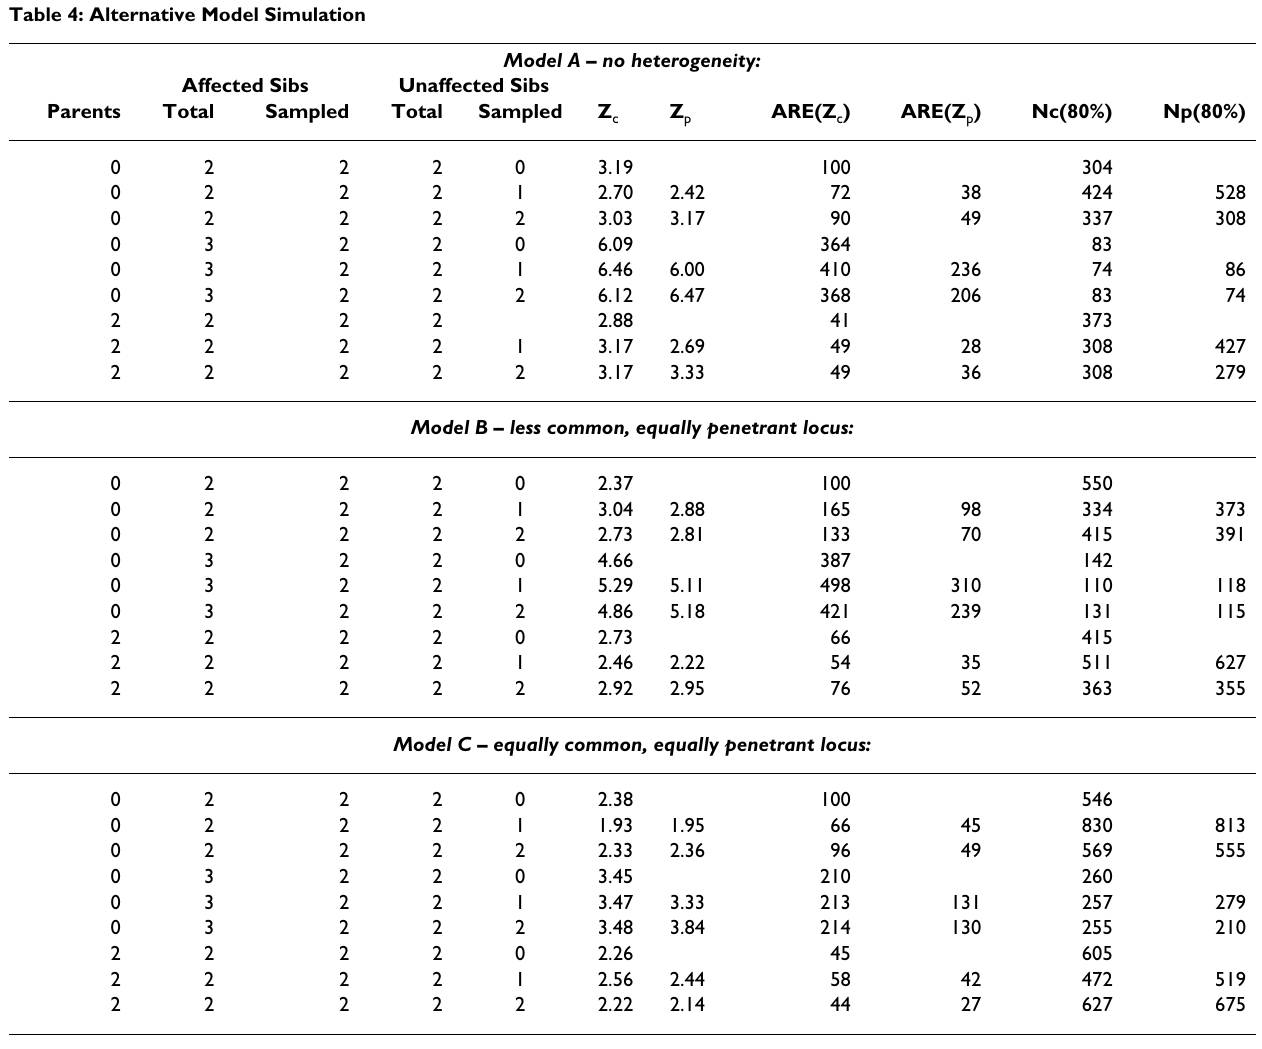
Table 4: Alternative Model Simulation